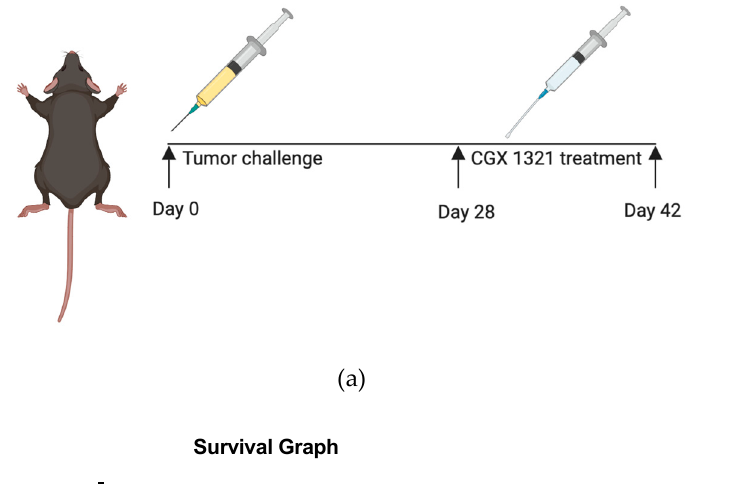
7 of 22 Figure 2. Wnt and immune gene signature in ovarian cancer patient samples. ( a ) T cell signatures and Relative Wnt Activity scores calculated from RNA-seq data for 57 treatment naïve human HGSC tissues show a negative correlation. ( b ) Kaplan–Meier curve for PFS ( n = 17) based on decreases in Wnt activity after NACT. ( c ) Kaplan–Meier curve for OS ( n = 17) in correlation with decreased